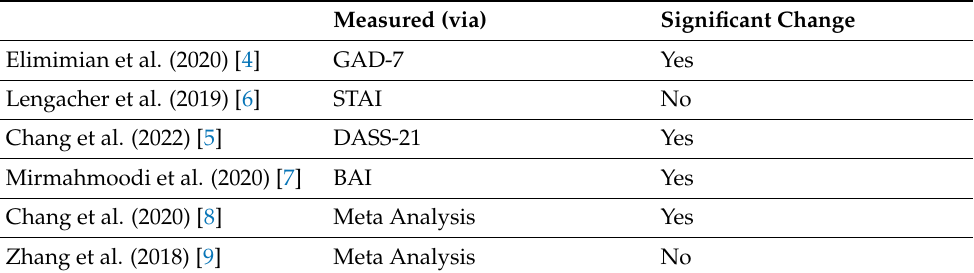
Table 11. Anxiety Outcomes